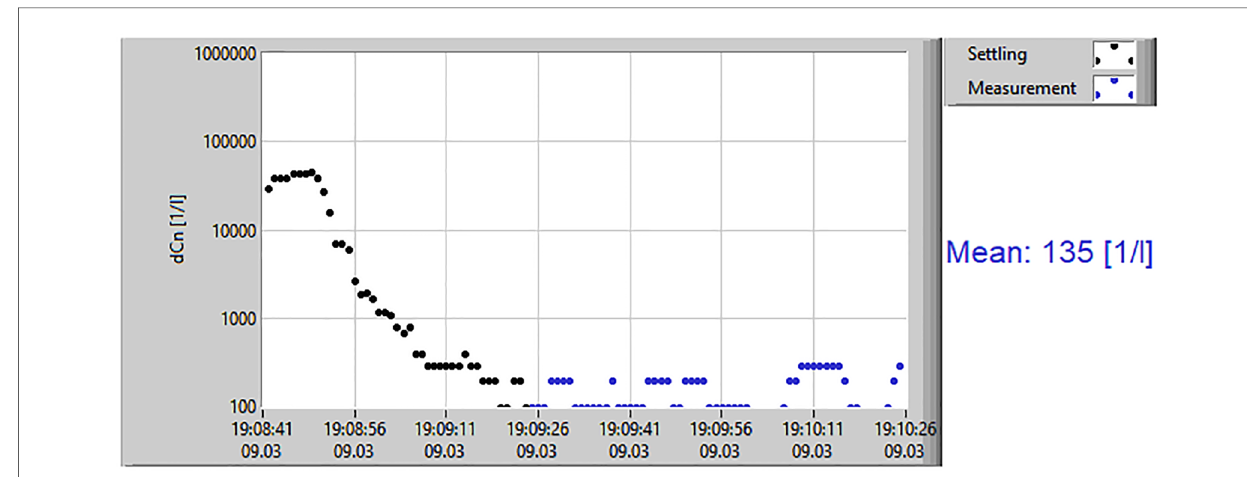
FIGURE 2 Results of aerosol measurement. The measurement results display the mean value of exhaled particles/liter, including a graphical chart of the measurement